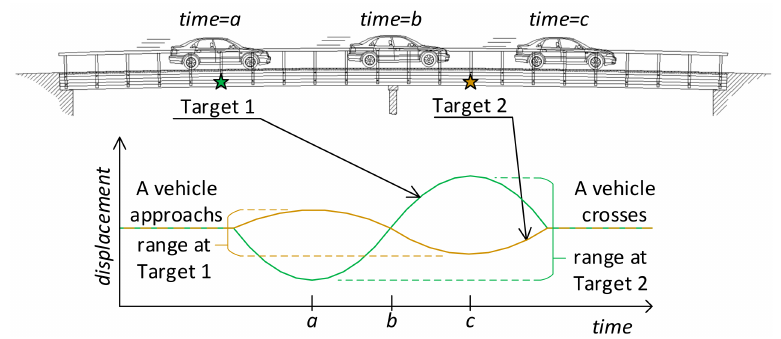
Figure 2. Estimating the displacement range at the target